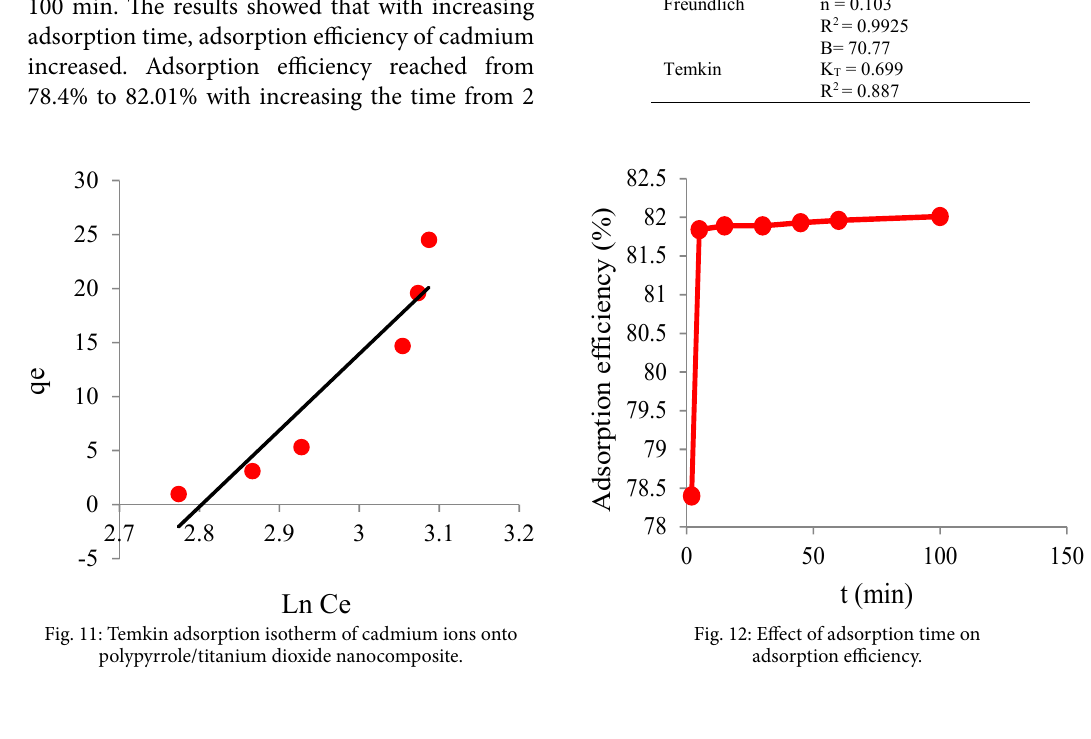
Fig. 12: Effect of adsorption time on adsorption